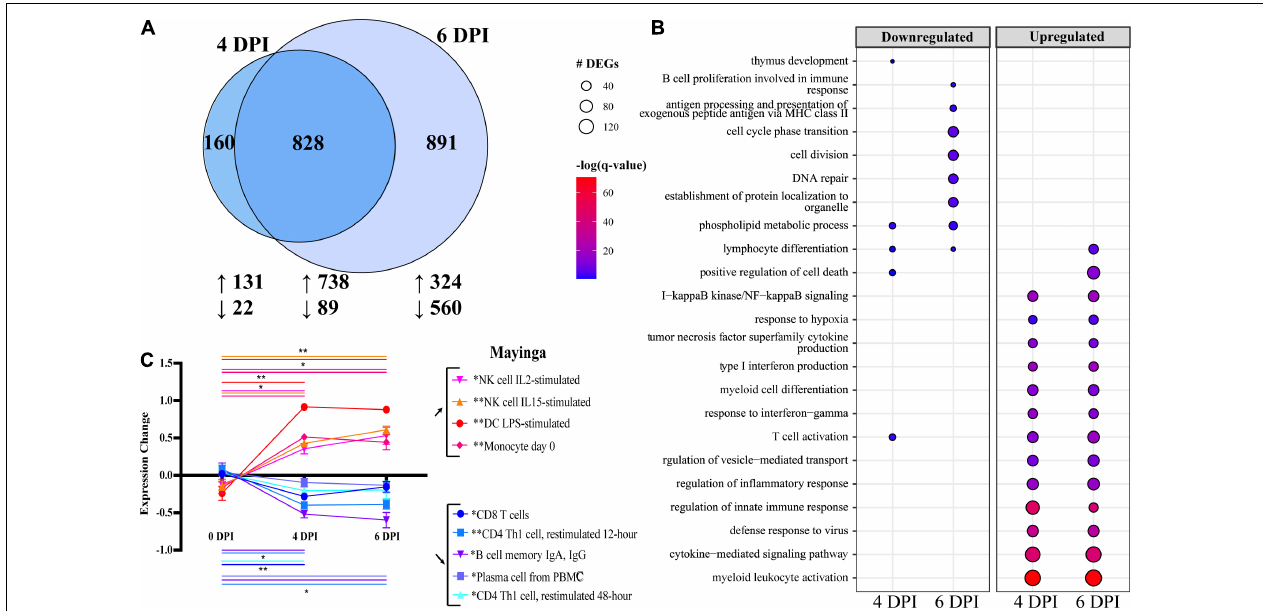
FIGURE 1 | Differential gene expression analysis with EdgeR following EBOV-Mayinga infection in rhesus macaques shows robust immune activation and dysregulation. (A) Venn diagram of number of differentially expressed genes (DEGs) (FDR ≤ 0.05, fold change ≥ 1 or 1, rpkm 5; see section “Materials and Methods”) detected at 4 and 6 DPI following EBOV-Mayinga infection. The number of upregulated and downregulated DEGs is indicate with upward- and downward-pointing arrows, respectively. (B) Bubbleplot summarizing functional enrichment of DEGs up- and downregulated 4 and 6 DPI. Color intensity of each bubble represents the negative log of the FDR-adjusted p -value [–log( q -value)], and the relative size of each bubble represents the number of DEGs belonging to the specified gene ontology (GO) term. (C) Digital cell quantification analysis using DMAP and IRIS datasets. Lines are color-coded to match both the subset listed in the legend. Significance lines of which both ends denote the two time points of the two-way multiple comparisons significance testing. Asterisks in legend cell population denote overall significance (0–4 DPI, 4–6 DPI, and 0–6 DPI) through the mixed effects model test. * p < 0.05, ** p < 0.01, *** p <